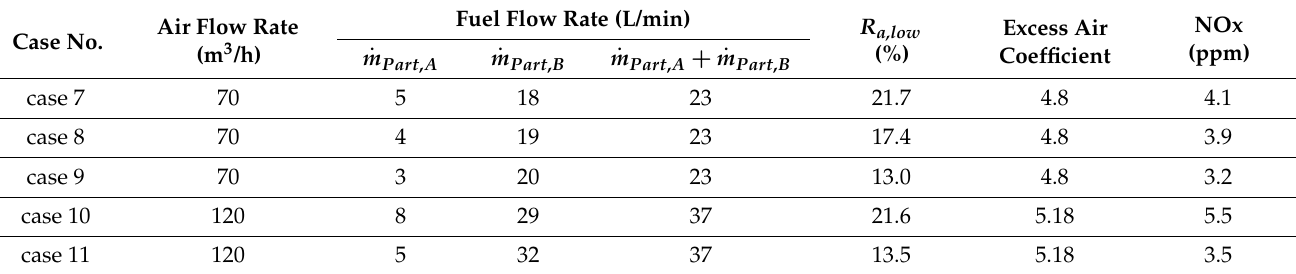
Table 2. NOx formation off blowout state under different fuel distribution ratios. Case